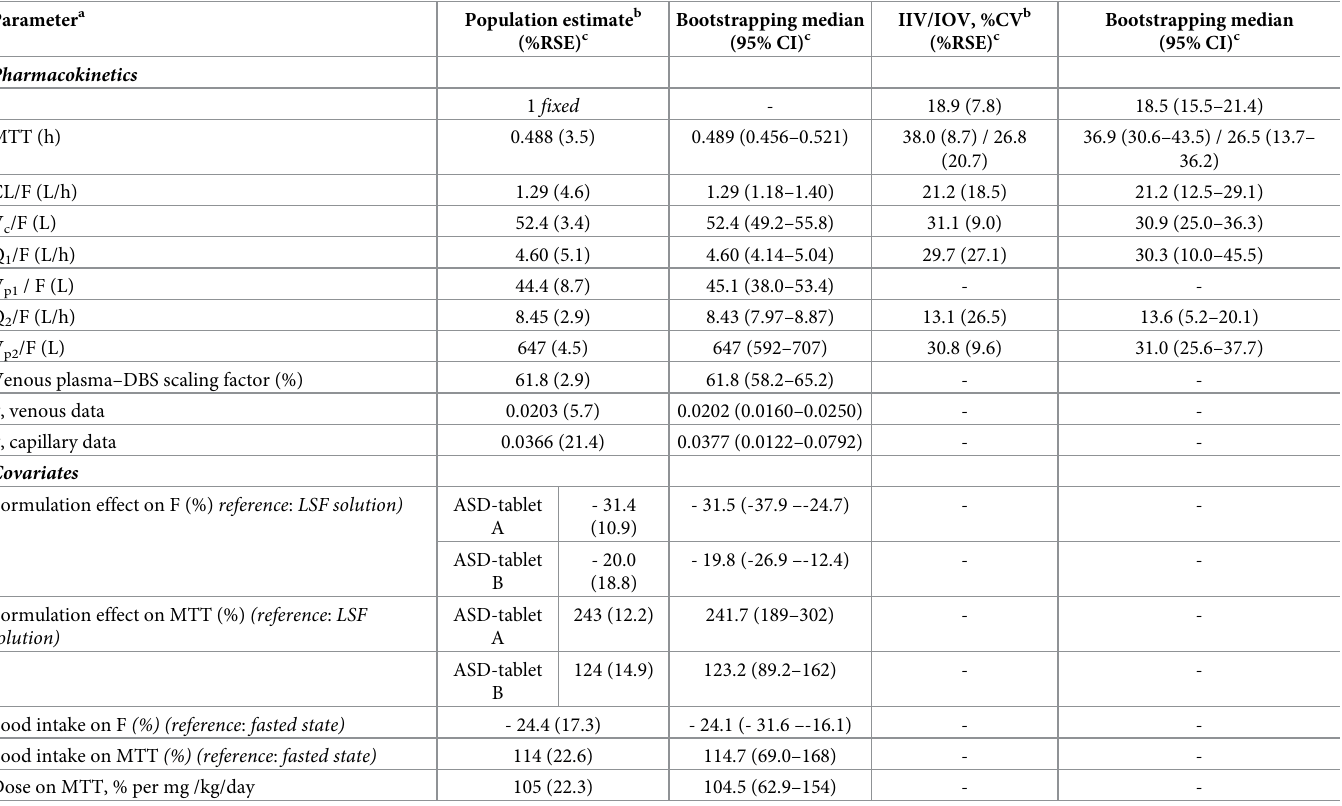
Table 3. Parameter estimates of the final population pharmacokinetic model of emodepside in healthy male